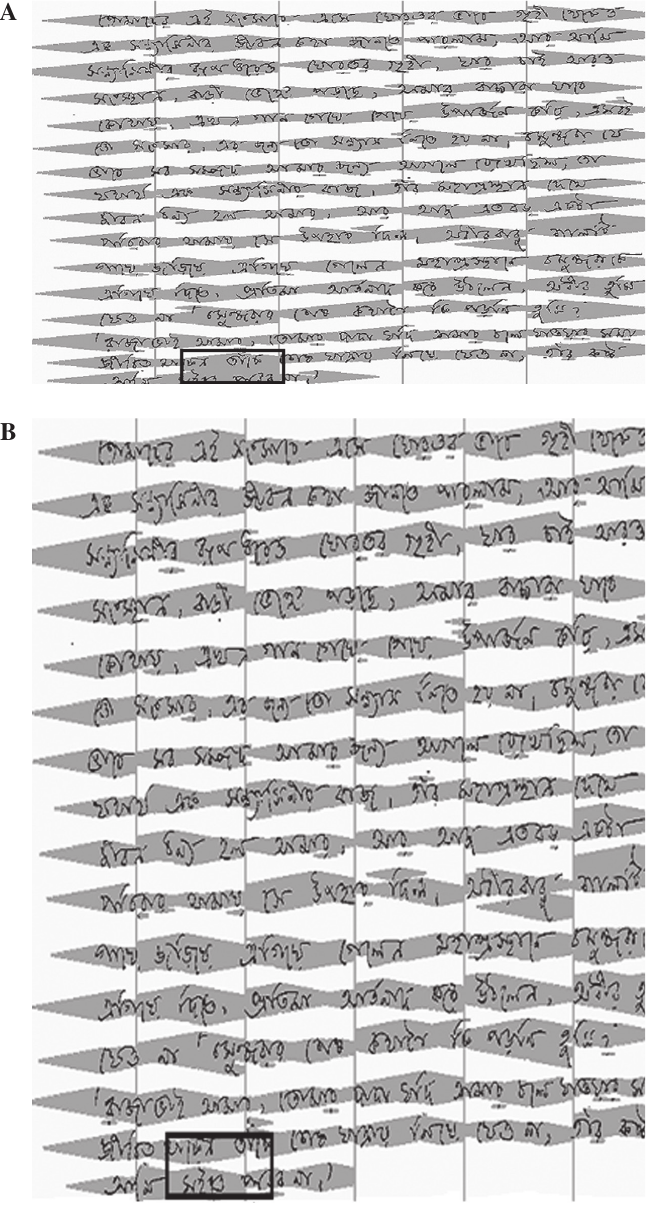
Figure 7. Accurate Localization and Subsequent Separation of Overlapping Text Lines Using the Current Technique Are Shown Within the Highlighted Rectangular